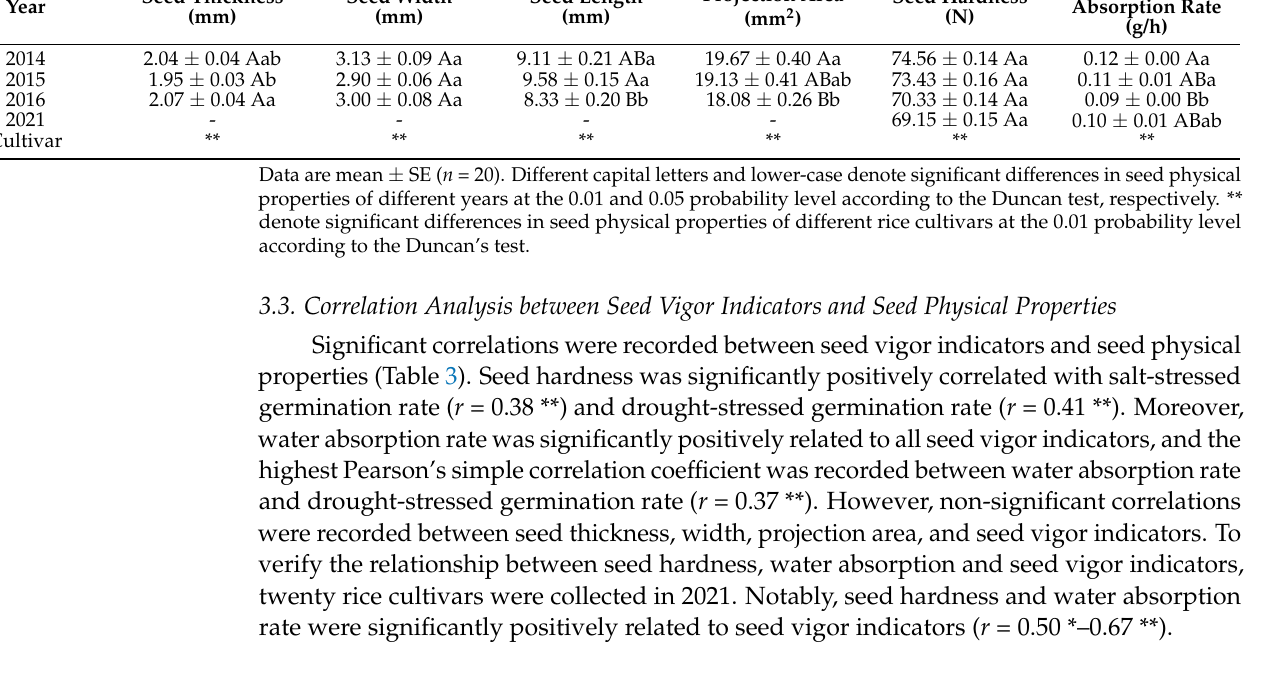
Table 2. MANOVA analysis of seed physical properties of different rice cultivars in different